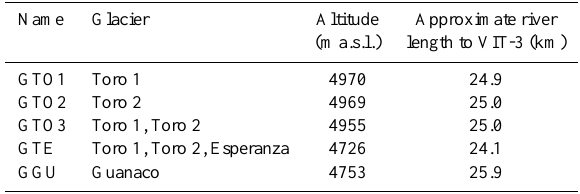
Table 4. Manual discharge measurement stations. Name Glacier Altitude Approximate river (ma.s.l.)